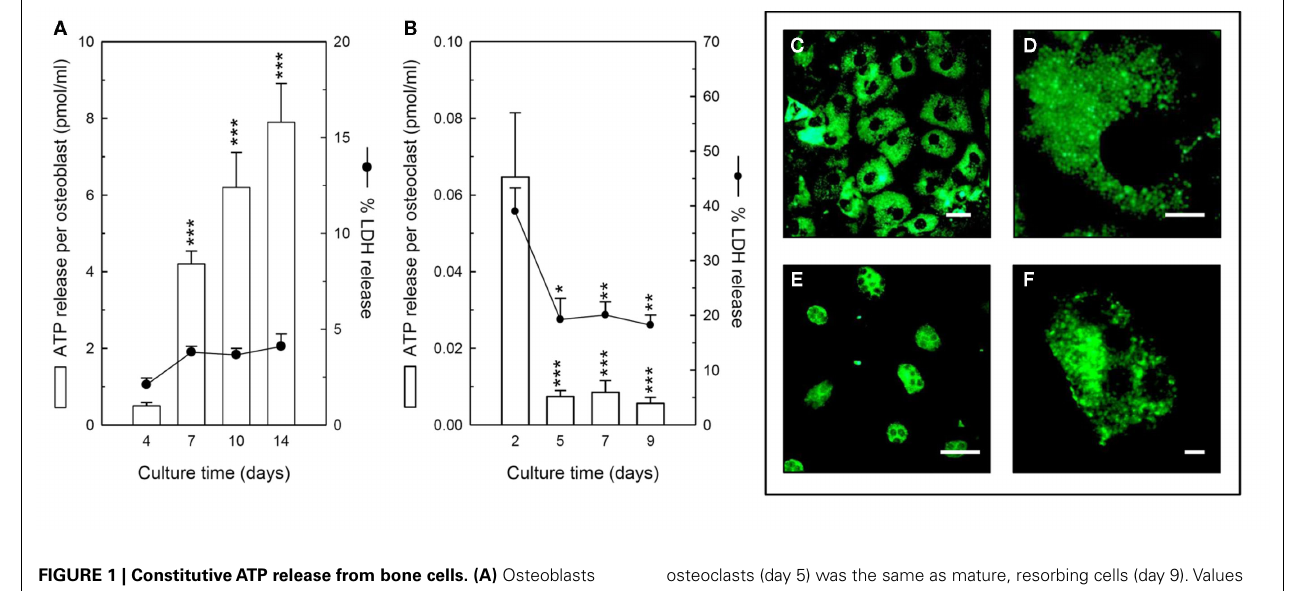
FIGURE 1 | ConstitutiveATP release from bone cells. (A) Osteoblasts released ATP constitutively throughout the culture period, with peak release from mature, bone-forming cells (day 14); cell viability remained similar at every stage of development. (B) Osteoclasts also constitutively released ATP throughout the culture period.The highest level of ATP release was detected from precursor cells (day 2), although this was accompanied by higher LDH levels indicating a reduced cell viability.The amount of ATP release from early